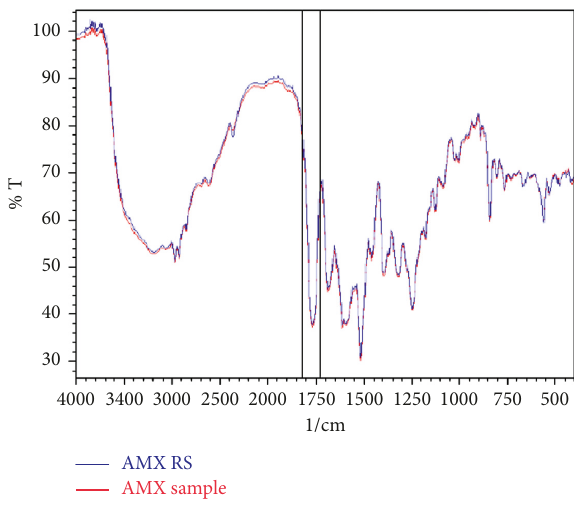
Figure 1: Overlap of the absorption spectra in the mid-infrared region of AMX RS and in the pharmaceutical dosage form of capsules. AMX RS: amoxicillin reference standard; AMX: amoxi- cillin. Spectral range chosen for quantitative analysis (from 1815 to 1 ) is 1736cm −